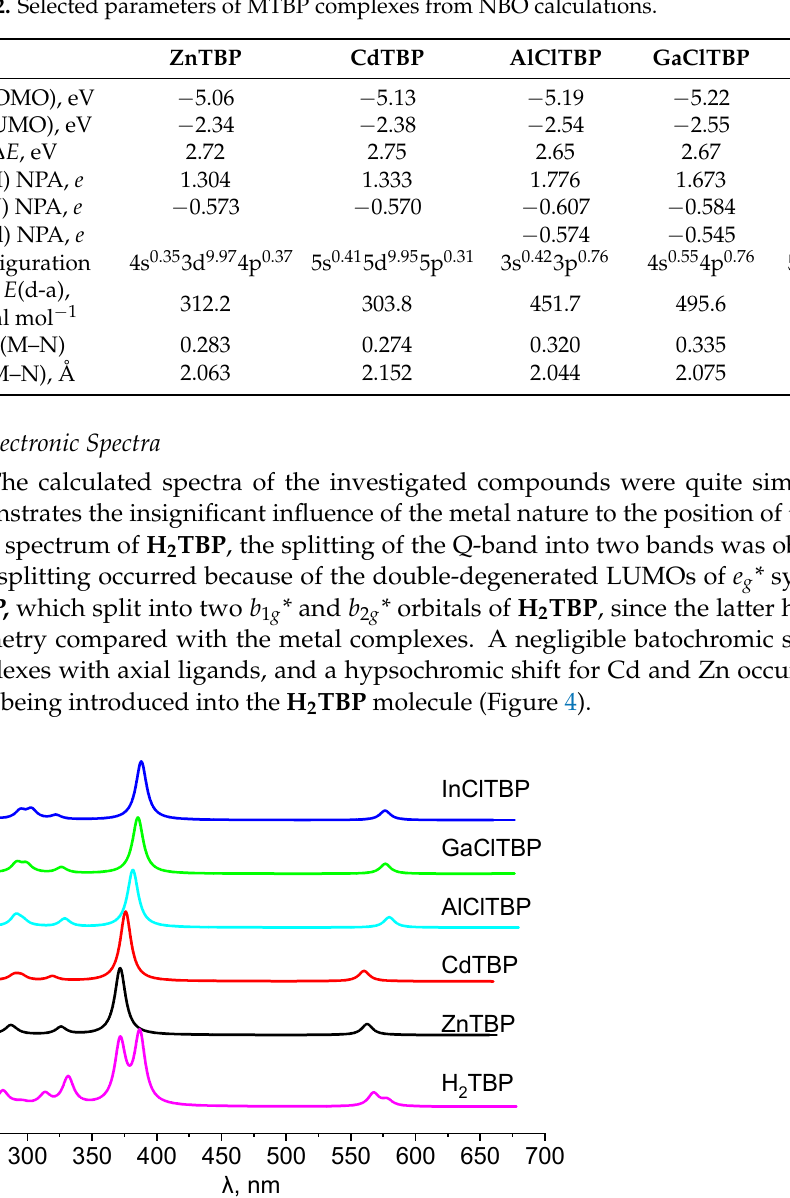
Table 2. Selected parameters of MTBP complexes from NBO calculations.